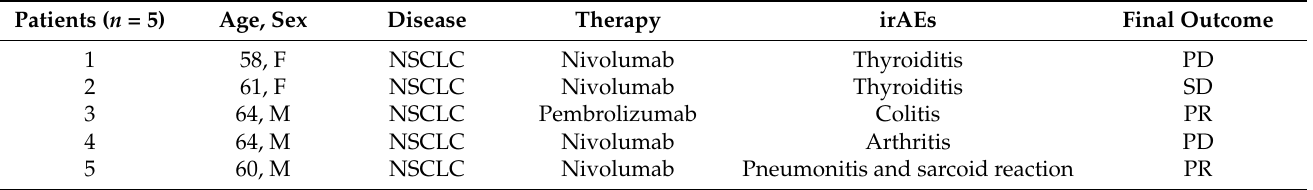
Table 2. Patients’